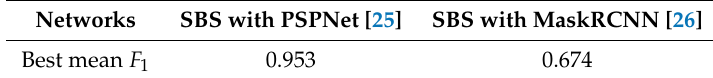
Table 1. Comparison of the best mean F 1 score achieved for two semantic networks used in combination with SBS on the CDNet 2014 dataset. These performances are obtained considering the SBS method, where the output of the BGS algorithm is replaced by the ground-truth masks. This indicates how the semantic information used in SBS would deteriorate a perfect BGS